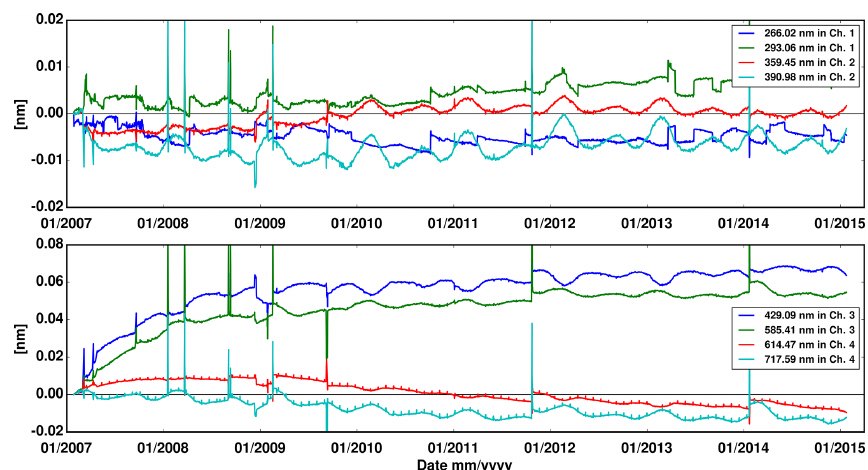
Figure 9. Difference of the centre line position with respect to January 2007 evaluated from a regular Gaussian fitting of well-separated SLS lines. The upper panel shows the results in channel 1 and 2 (blue line 266.02nm in channel 1, green line 293.06nm in channel 1, red line 359.45nm in channel 2, and turquoise line 390.98nm in channel 2). The lower panel shows results for channel 3 and 4 (blue line 429.09nm in channel 3, green line 585.41nm in channel 3, red line 614.47nm in channel 4, and turquoise line 717.59nm in channel